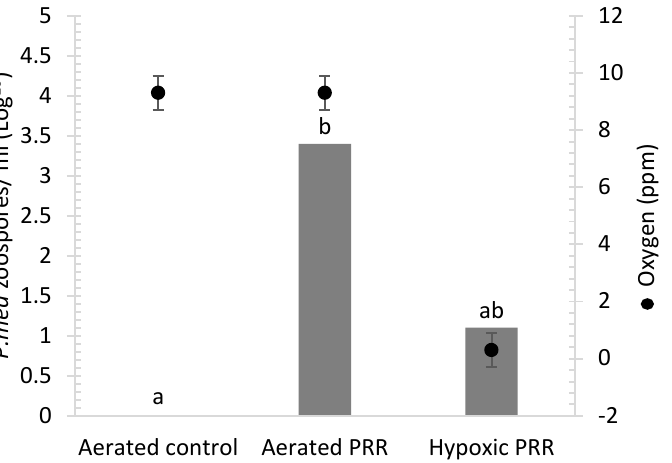
Figure 8. Predicted mean Phytophthora medicaginis ( P.med ) zoospore counts (F = 4.2, p < 0.05) for three aeration × Phytophthora root rot ( P.med ) inoculated treatments and the associated oxygen with CI (ppm) (F = 540.0, p < 0.001) for a hydroponic chickpea experiment with three genotype sub-treat- ments listed in Experiment 3. Letters indicate significant differences.